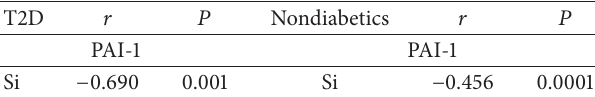
Table2:Correlationbetweensensitivityindex(Si)andplasminogen activator inhibitor-1 (PAI-1) levels in patients with type 2 diabetes